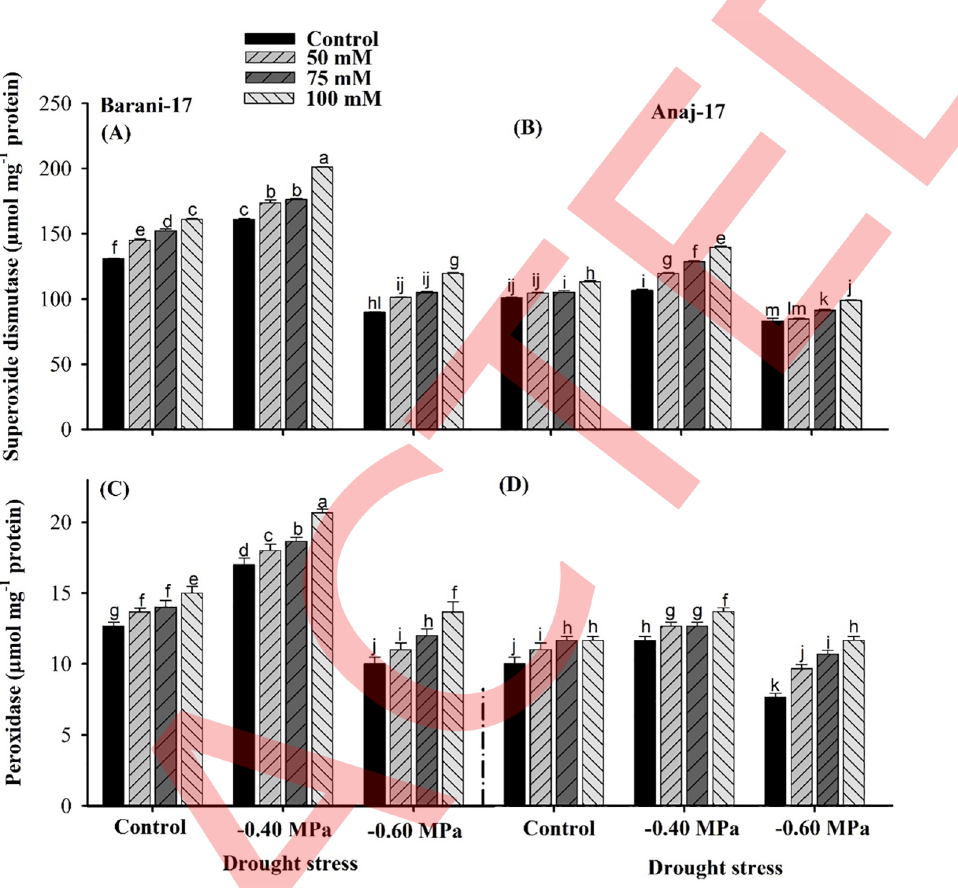
Fig 2. Influence of salicylic acid application on superoxide dismutase (A, Barani-17 and B, Anaj-17) and peroxidase content (C, Barani-17 and D, Anaj-17) of two wheat cultivars under drought stress. Different letters indicate significant difference between the treatments according to Turkey’s HSD test ( p <